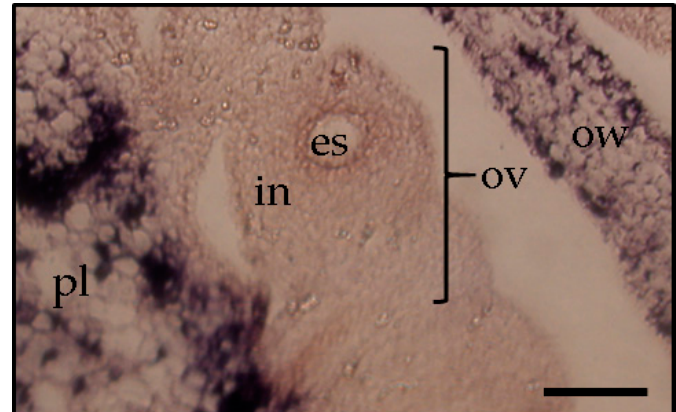
Figure 5. In situ hybridization shows the presence of potato spindle tuber viroid in the ovary wall (ov) and placenta (pl), but not the ovule (ov), which comprise the embryo sac (es) and integument (in), respectively, in a flower of an infected eggplant ( Solanum melongena ) at the flower opening stage. Scale bars = 100 μ bars = 100 μ m.